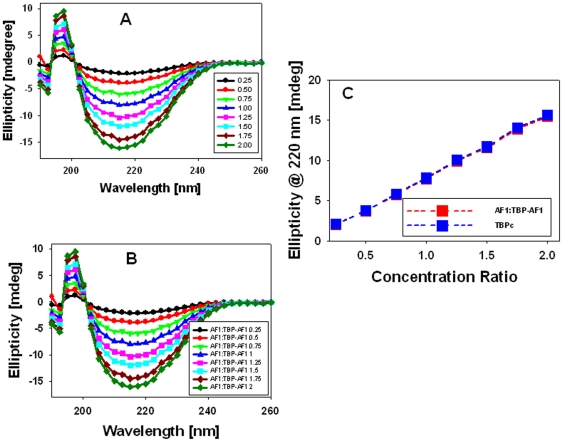
Secondary structural analyses of TBPC.
A) Far-UV CD spectra of the TBPC at various concentrations. B) Far-UV CD spectra showing TBPC after subtracting the contribution of AF1 in each case. C) A comparison of changes in the ellipticity at 220 nm for TBPC alone and AF1∶TBPC – AF1 at various concentrations of TBPC.